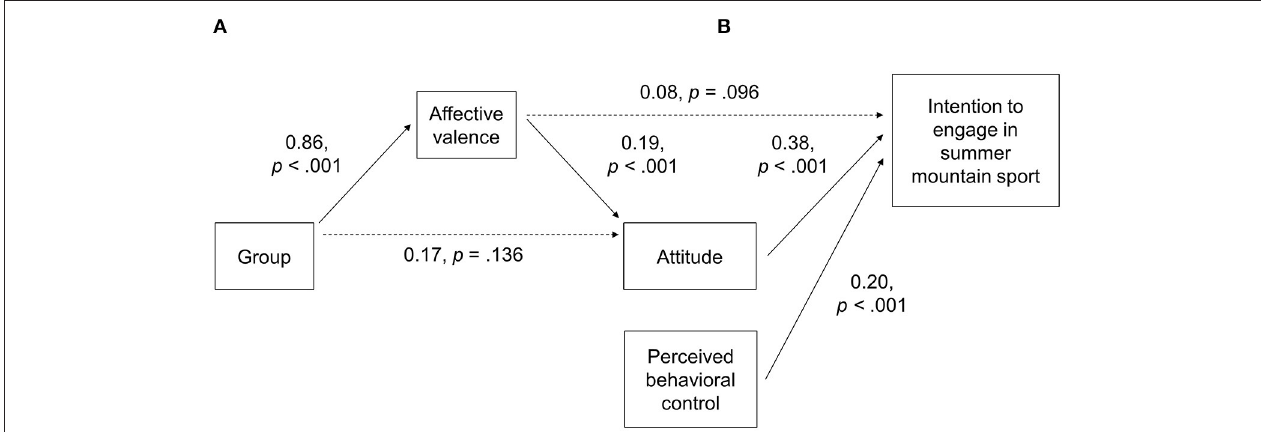
FIGURE 4 | Regression analysis of (A) attitude as an outcome of group allocation or affective valence and (B) hierarchical regression analysis of intention to engage in summer mountain sport as an outcome of attitude, perceived behavioral control (model 1), and affective valence (model 2). Path coefficients show standardized regression coefficients. Solid lines indicate statistically significant coefficients; dashed lines indicate non-significant